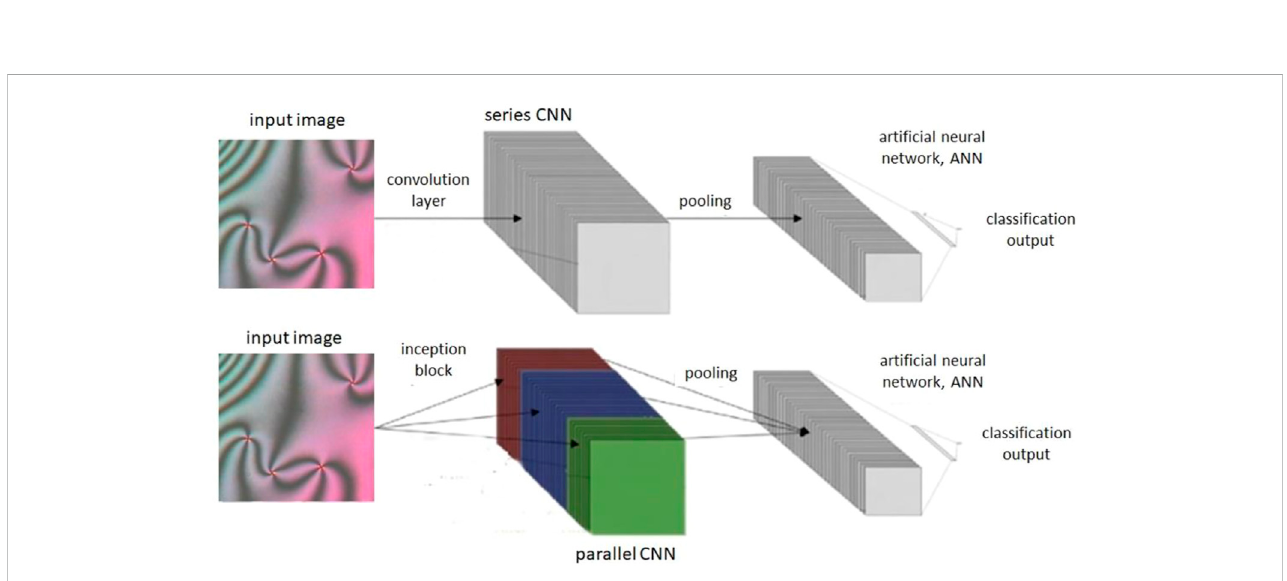
FIGURE 3 Diagram ofaCNNwith oneconvolutionlayer andan Inception model withone Inception block, eachfollowedbyapooling layerand ANN. Feature map outputs for each layer ’ s fi lters are shown as